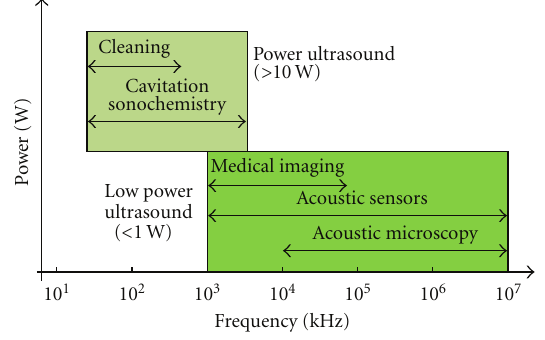
Figure 1: Utilizations of ultrasound according to frequency and